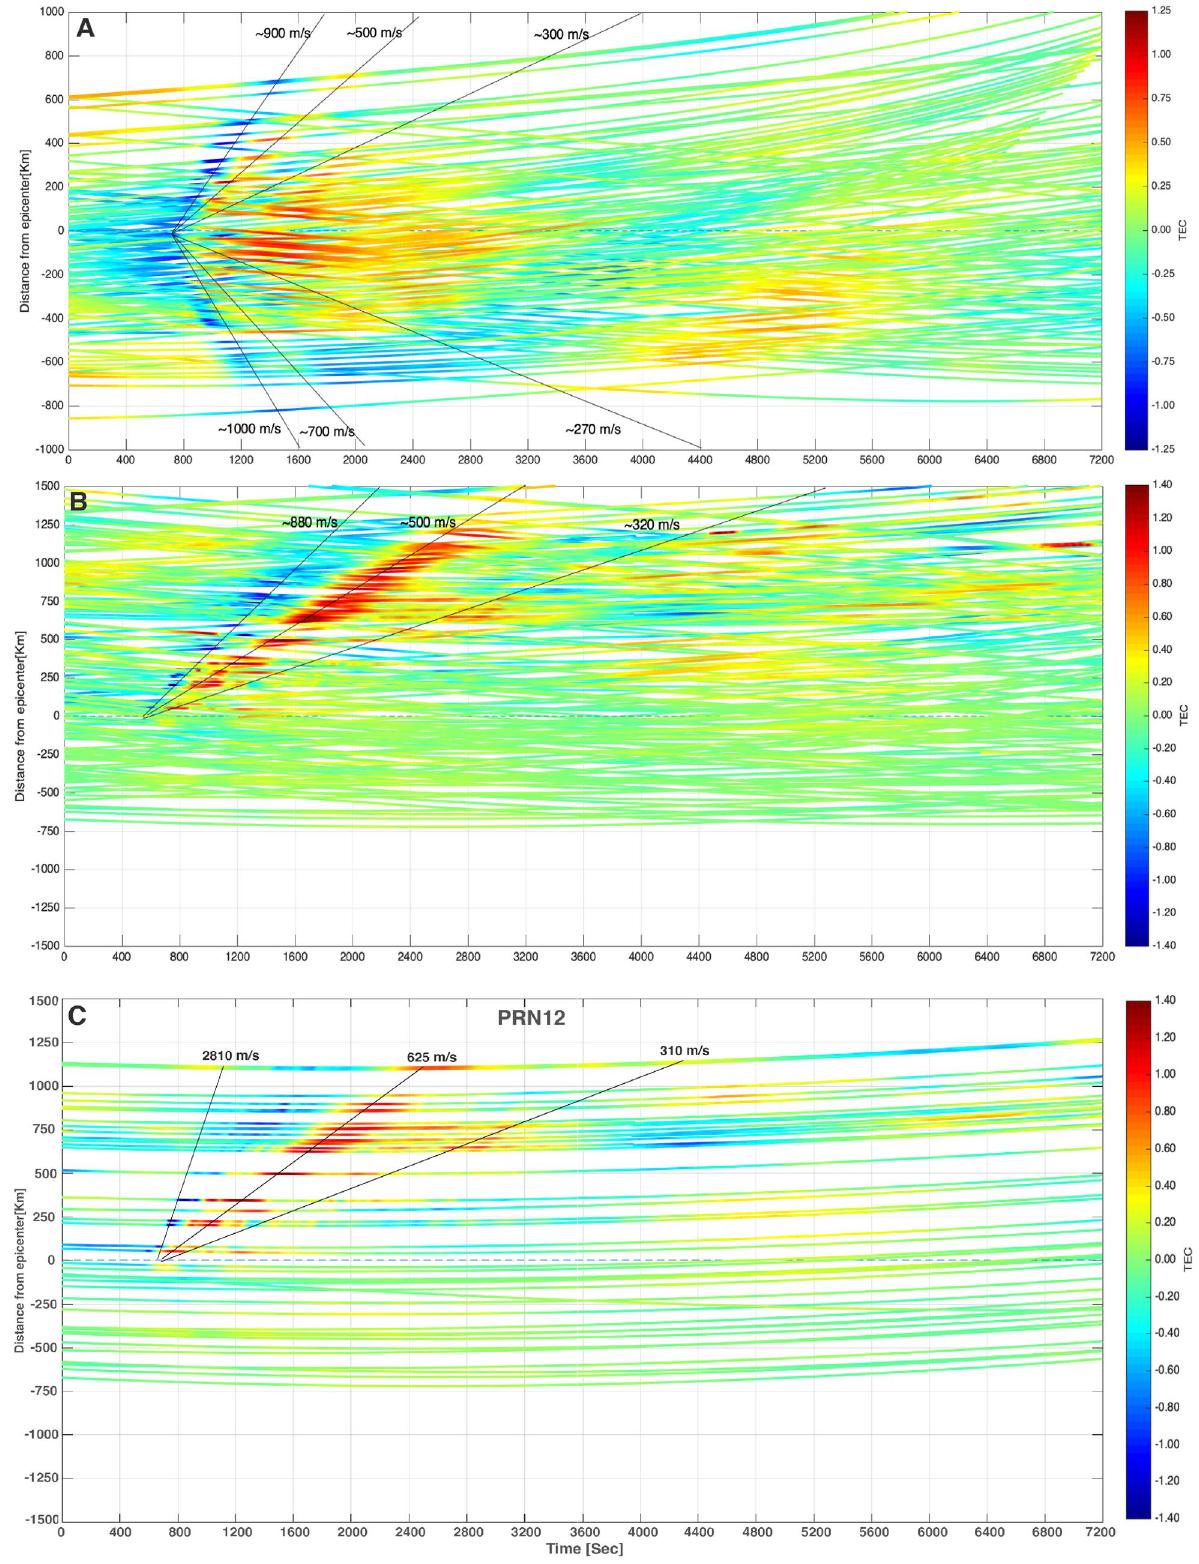
Figure 5. (A) Hodochrone map shows variations in VTEC for PRNs 01, 11, 20, and 23 for GPS sites for two hours duration from 23 to 1 h next day of the Pisagua earthquake on April 1, 2014. (B) Hodochrone plot shows residual VTEC at various GPS sites as a function of time and epicentral distance, as obtained from PRNs 2, 12, 24, and 25 for GPS sites for two hours duration from 22 to 24 h of the Illapel earthquake on September 16, 2016. The positive and negative epicentral distances indicate the northern and southern directions regarding the Illapel earthquake epicenter, respectively. (C) The signature of AW Rayleigh is shown in TEC data of PRN12 in the